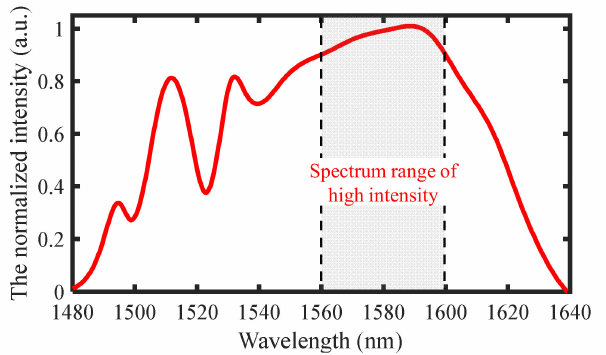
Figure 5. The spectrum of a femtosecond laser used for the angular measurement investigation; the spectrum range of high intensity is from 1560 nm to around 1600